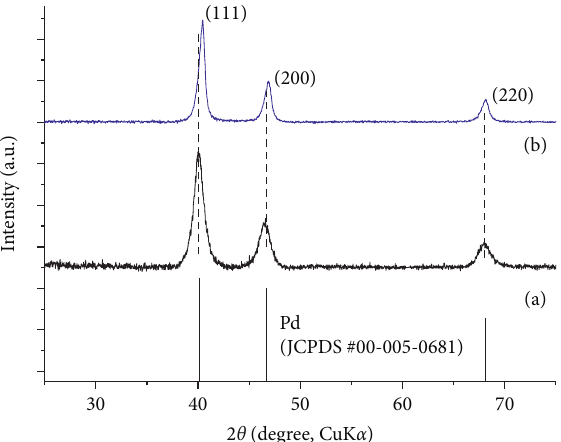
Figure 1: XRD patterns of nanocatalysts: (a) Pd-20EG-20NaBH